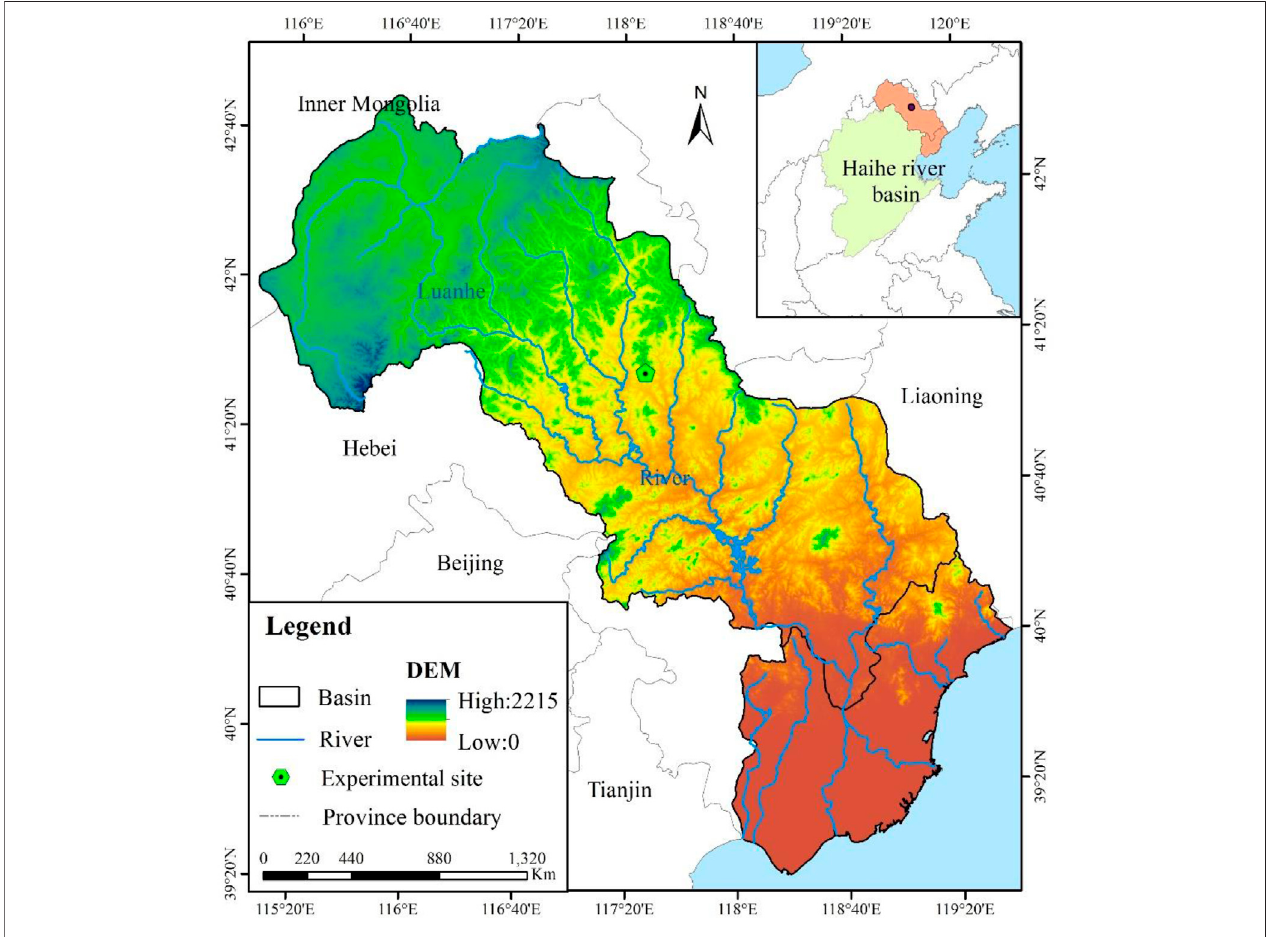
FIGURE 1 | Study area and the location of the experiment